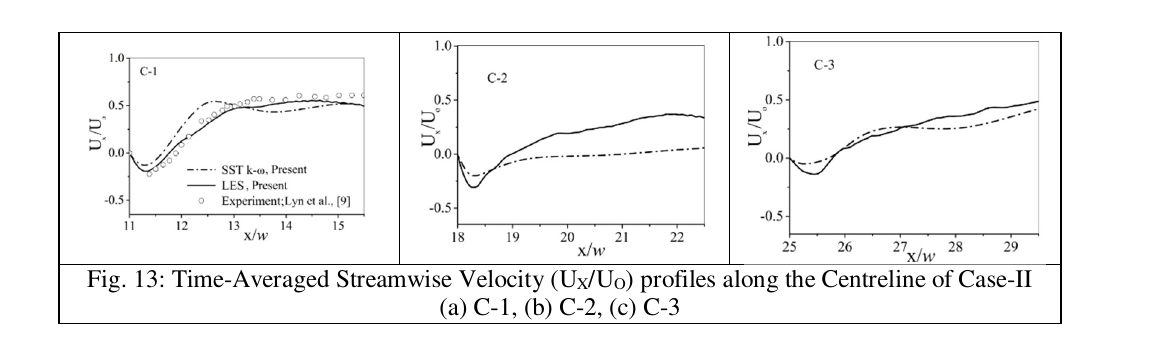
Fig. 13: Time-Averaged Streamwise Velocity (U X /U O ) profiles along the Centreline of